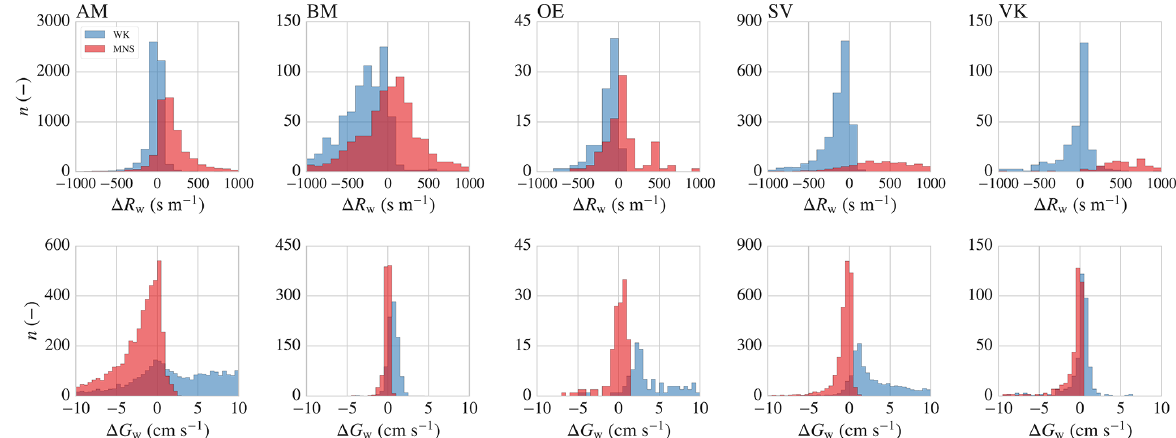
Figure 4. Differences in measured and modeled 30min nighttime non-stomatal resistances ( R w , upper row, 100sm − 1 bins) and conductances ( G w , lower row, 0.5cms − 1 bins). (cid:49)R w = R w , modeled − R w , observed and (cid:49)G w = G w , modeled − G w , observed , i.e., positive values indicate an overestimation and negative values indicate an underestimation by the models. Note that an overestimation of R w leads to an underestimation of fluxes F t , whereas an overestimation of G w leads to an overestimation of F t